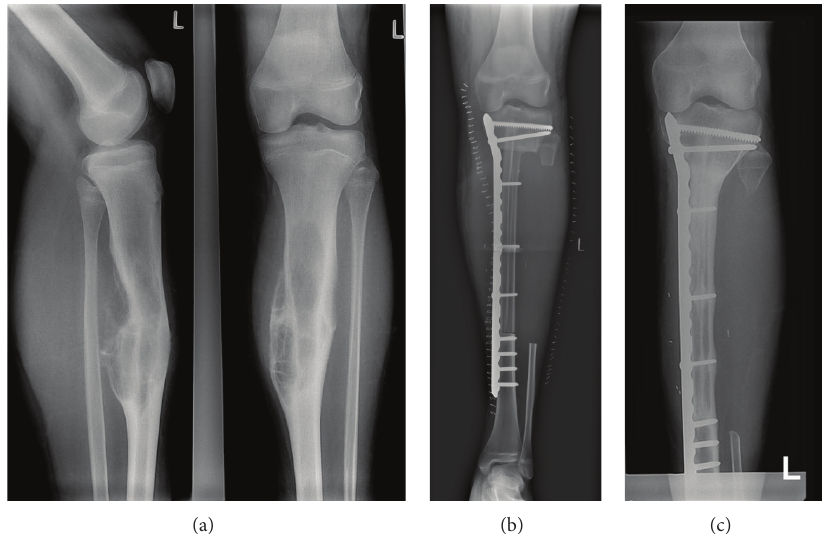
Figure 2: (Patient no. 9) (a) 14-year-old boy with Ewing’s sarcoma of the left tibia proximal diaphysis. (b) After completion of neoadjuvant chemotherapy wide resection and reconstruction of the defect (24.5 cm) by a vascularized transposed ipsilateral and contralateral free fibula and medial plate fixation were realised. (c) Radiograph showing osseous integration and hypertrophy of fibular grafts 15 months after